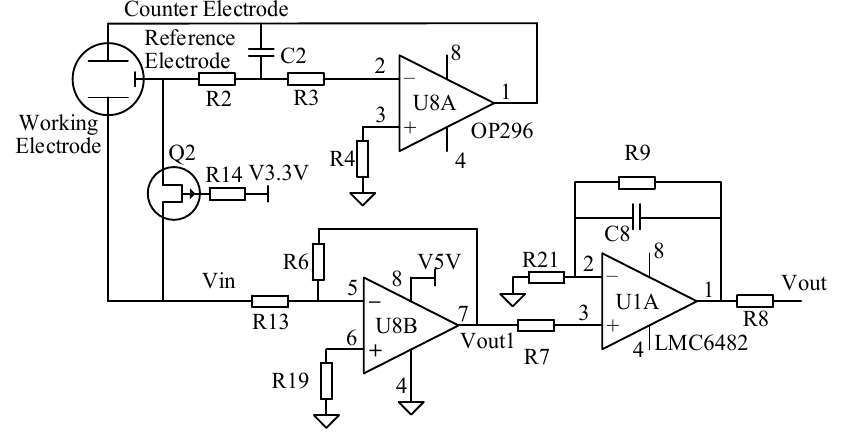
Figure 2. Measurement Circuit and Signal Conditioning Circuits of the Sensor.